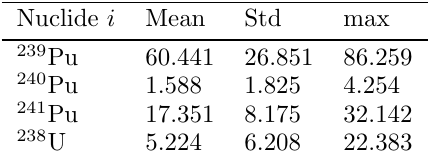
Table 5. Mean, Std and maximum values of the fractions f i for neutron production of some nuclides from the MOX